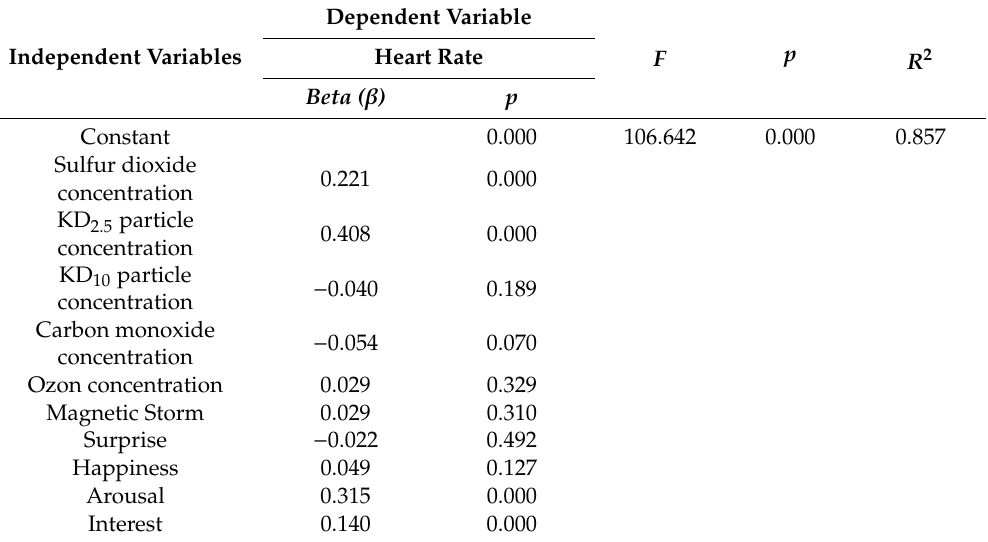
Table 11. Correlation analysis results for heart rate and its dependent